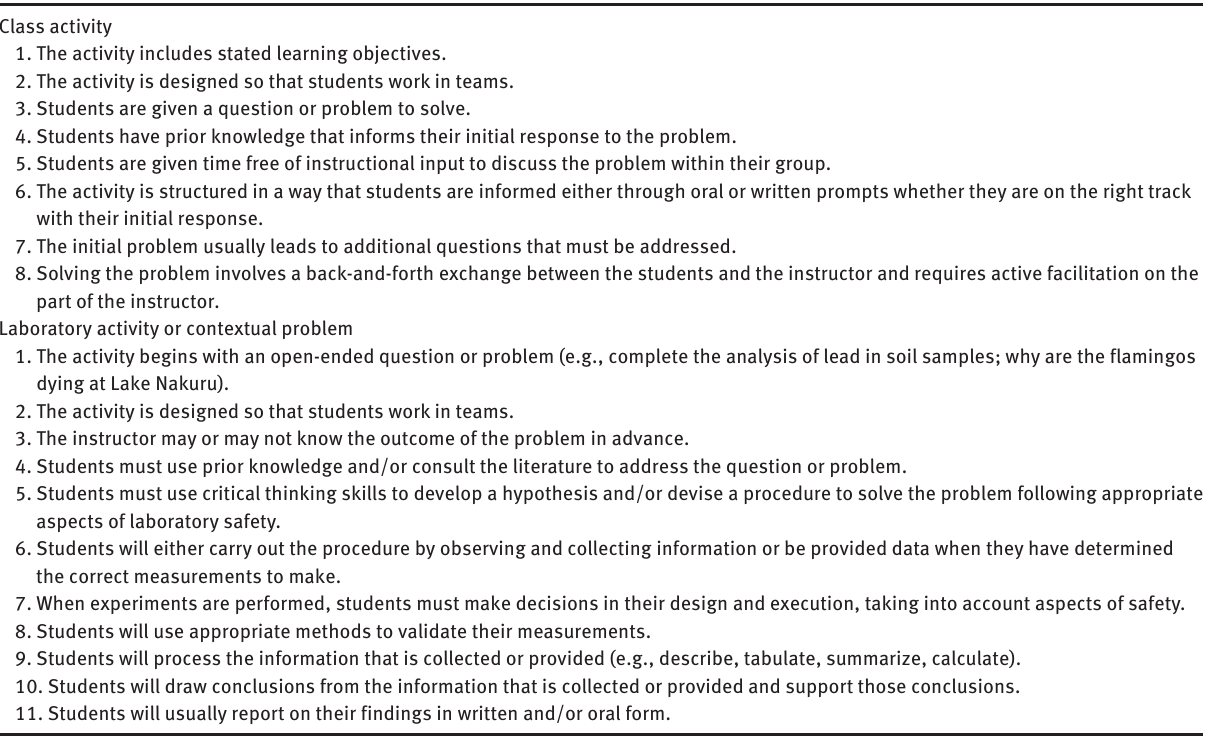
Table 3 Criteria used to define the meaning of an active learning